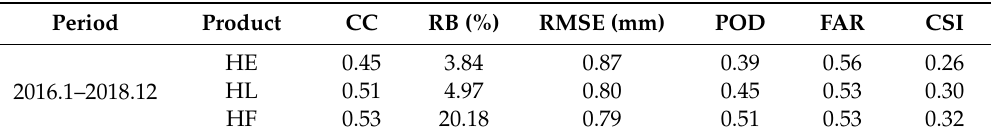
The continuous and contingency statistical metrics of the IMERG-HE, IMERG-HL, and IMERG-HF